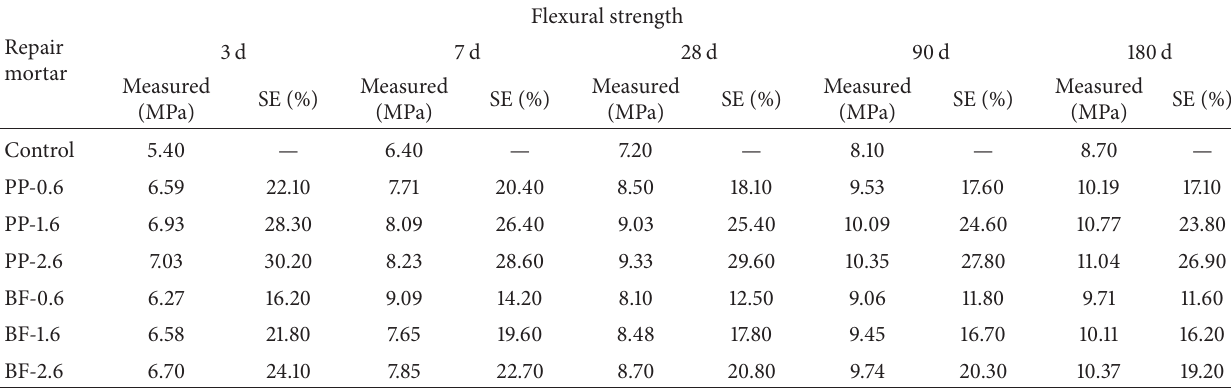
Table 5: Flexural strength test results of the mortar.